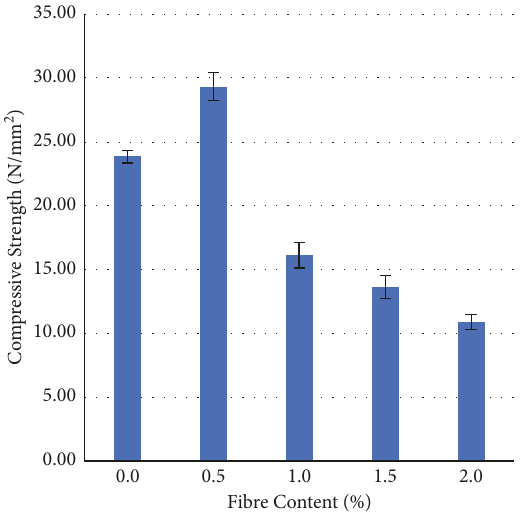
Figure 4: Effects of fibre addition on compressive